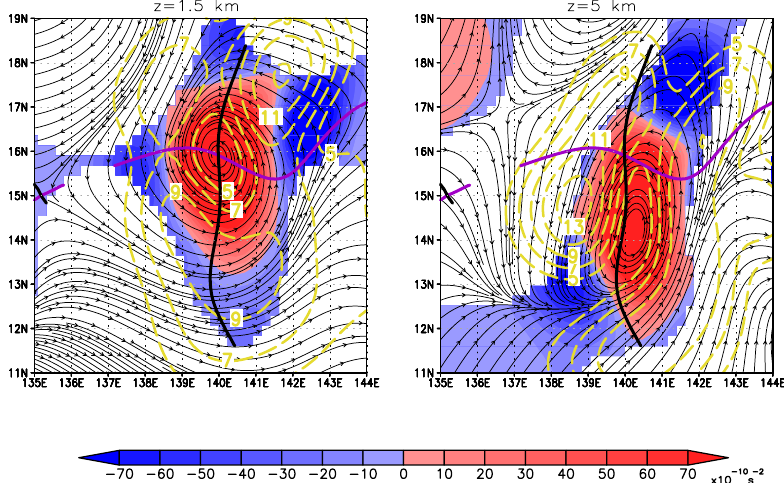
Figure 6. Two-panel plot of Okubo–Weiss (OW, shaded) and streamlines (co-moving) for Nuri 2 at 1.5km (left) and 5km (right) height from the 25km SAMURAI analysis. The thick purple line indicates the position of the 1.5km critical latitude and the thick black line indicates the position of the 1.5km wave trough. The dashed yellow lines are isotachs contoured at 2ms − 1 intervals. The OW is only shaded in regions with cyclonic relative vorticity. The abscissa is longitude and the ordinate is latitude.